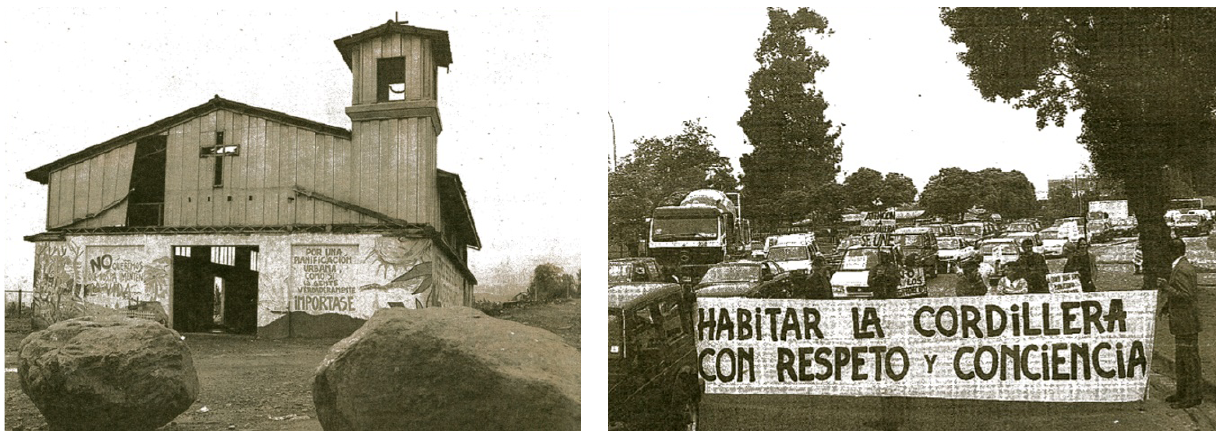
Figure 2. From left to right: The Santa Teresa Chapel (C. Gutiérrez, 1997) and a protest during the post-disaster conflict in the foothills (P. Gutiérrez,